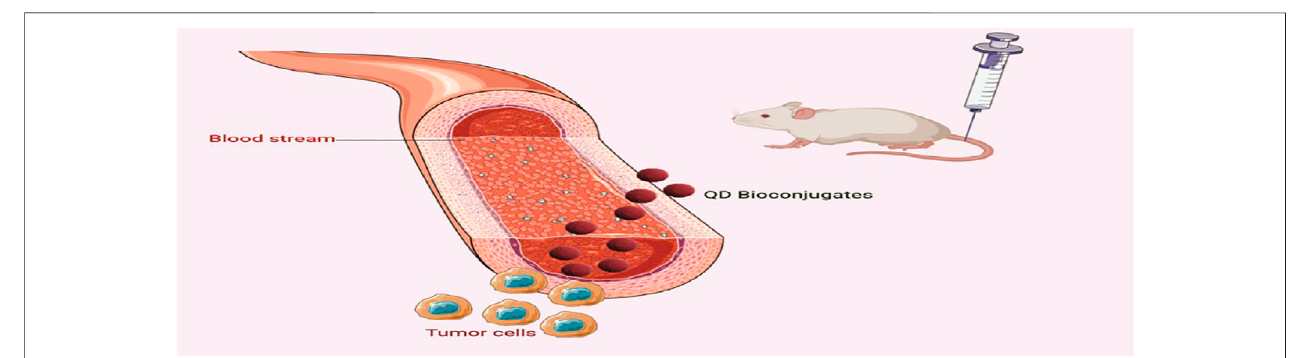
FIGURE 9 | Schematic representation for the role of QDs-bioconjugates in cancer diagnosis.